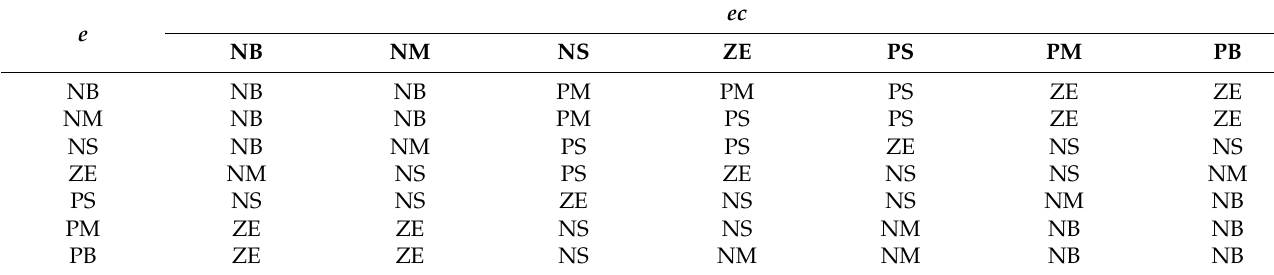
500 Hz, the results are as presented in Figure 13.